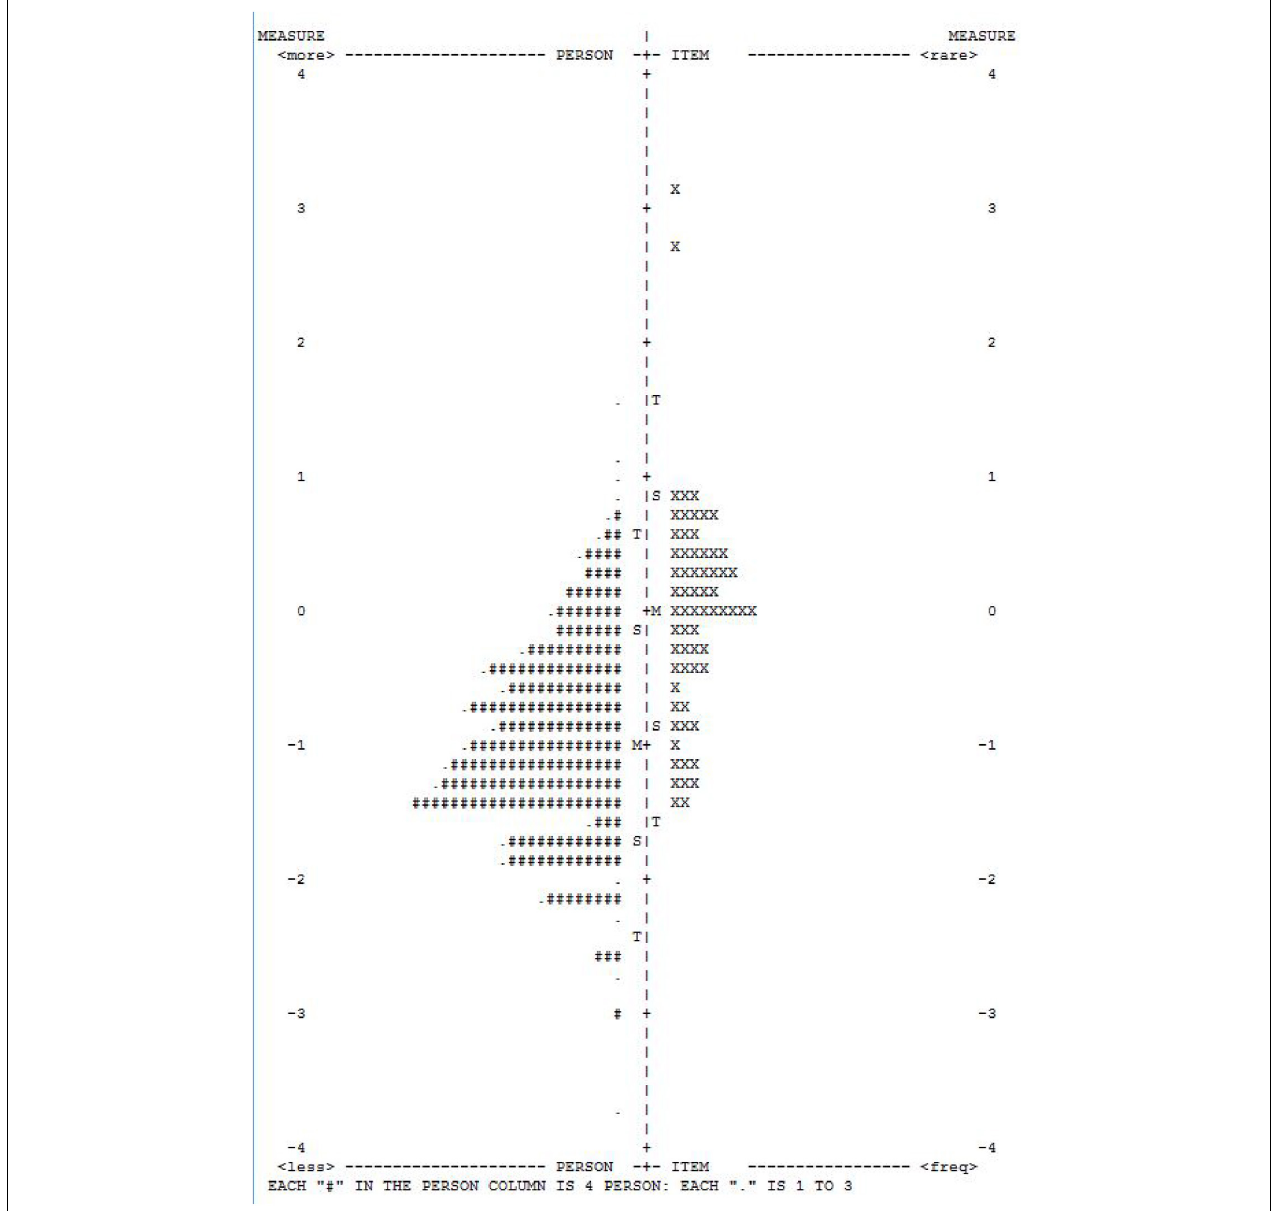
FIGURE 2 | Variable map for the STEM Student Reasoning Assessment calibration which illustrates the match between person measures and item measures. EACH (cid:48)(cid:48) # (cid:48)(cid:48) IS 7: EACH (cid:48)(cid:48) . (cid:48)(cid:48) IS 1 TO